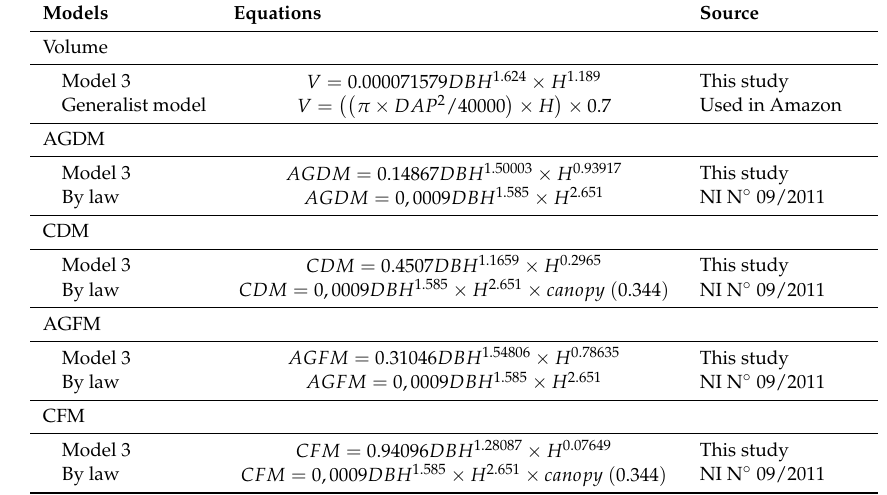
(cid:1829)(cid:1830)(cid:1839) = 0,0009(cid:1830)(cid:1828)(cid:1834) (cid:2869).(cid:2873)(cid:2876)(cid:2873) × (cid:1834) (cid:2870).(cid:2874)(cid:2873)(cid:2869) × (cid:1855)(cid:1853)(cid:1866)(cid:1867)(cid:1868)(cid:1877) (cid:4666)0.344(cid:4667)